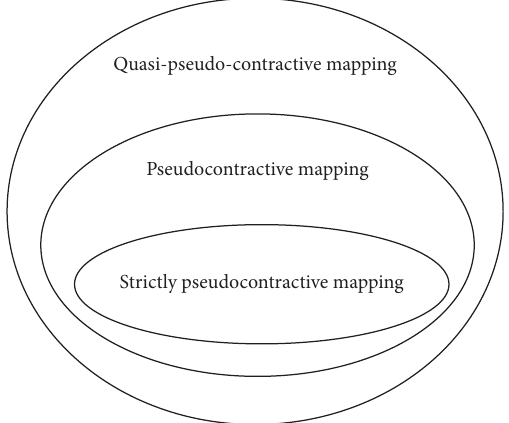
Figure 6: The relations of some nonlinear operators.